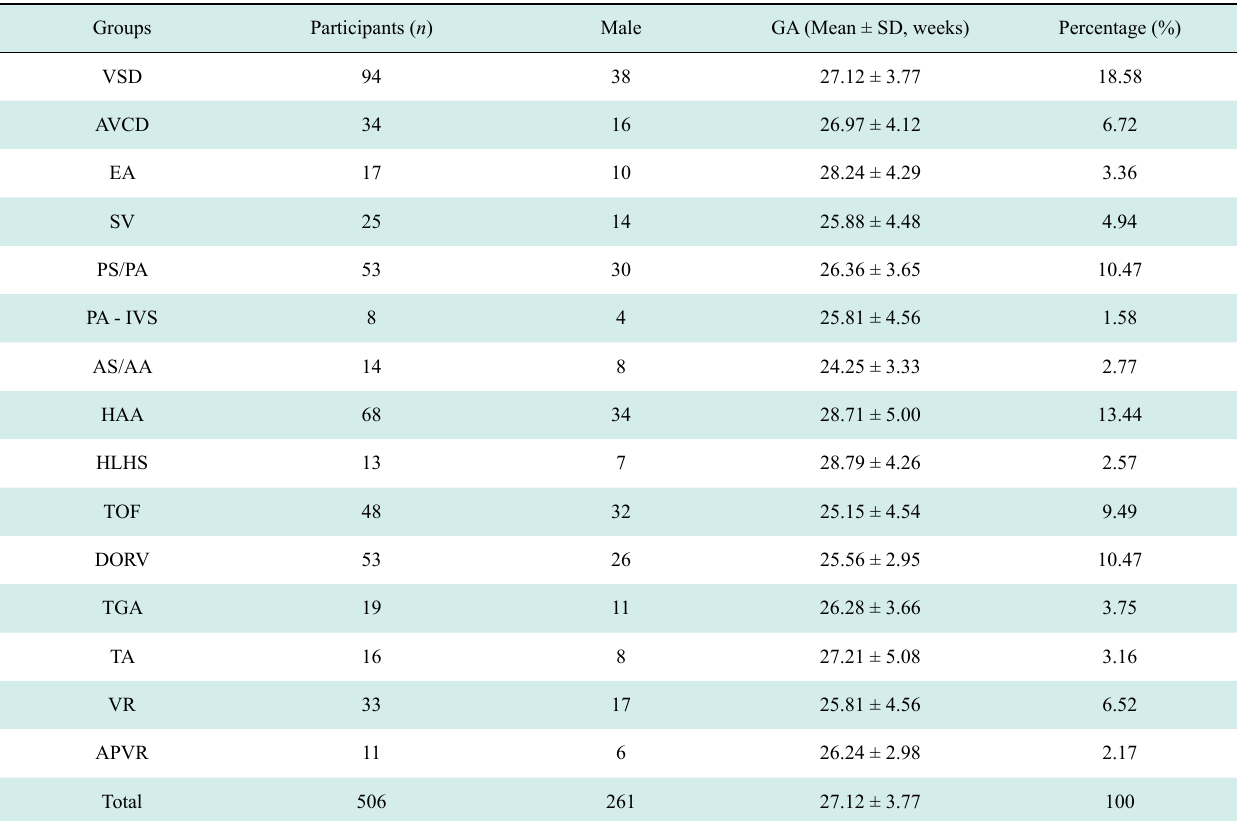
Table 1 Demographic data for all participants Groups